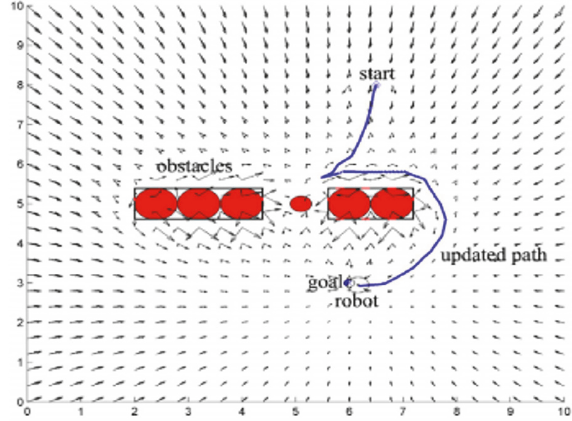
Figure 8: Unknown obstacle detected during navigation using BPF approach (source [6]).